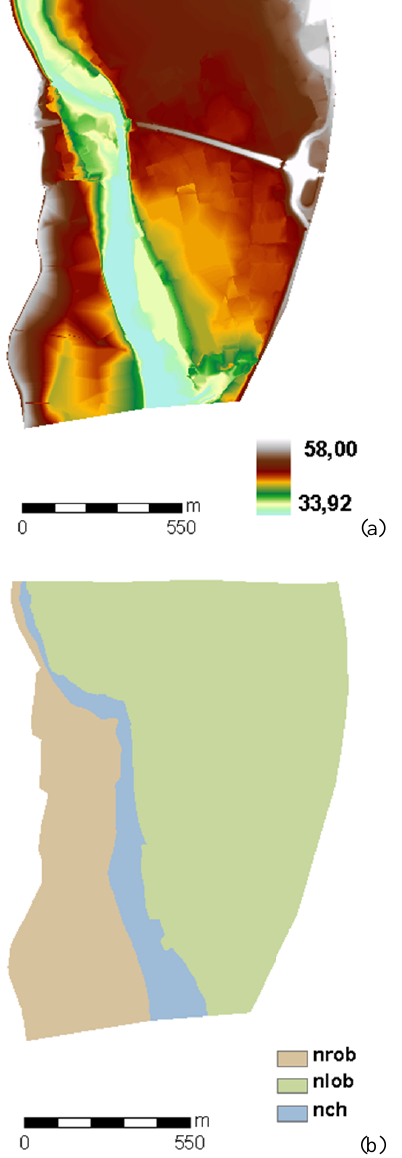
Fig. 1. Digital Elevation Model of the study river reach (a) and zones considered for different bed friction values (b)